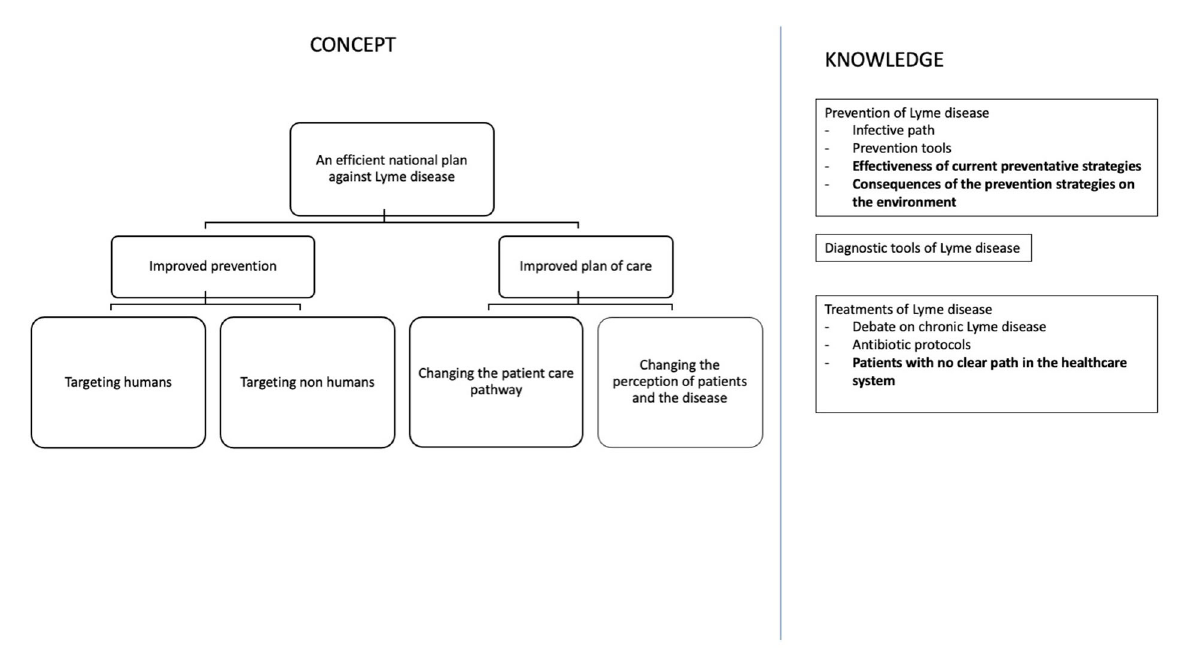
FIGURE4 First partitions of the final concept diagram (CKf) and main new mobilized knowledge in bold.